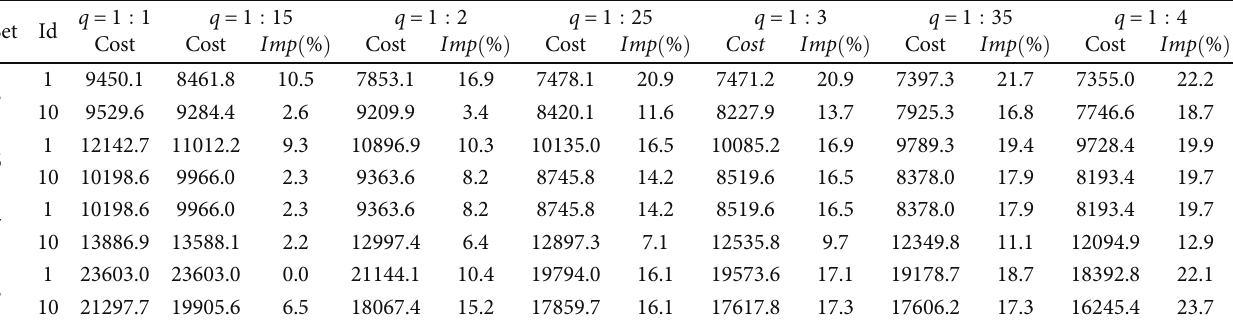
Table 5: Impact of the vehicle capacity Q